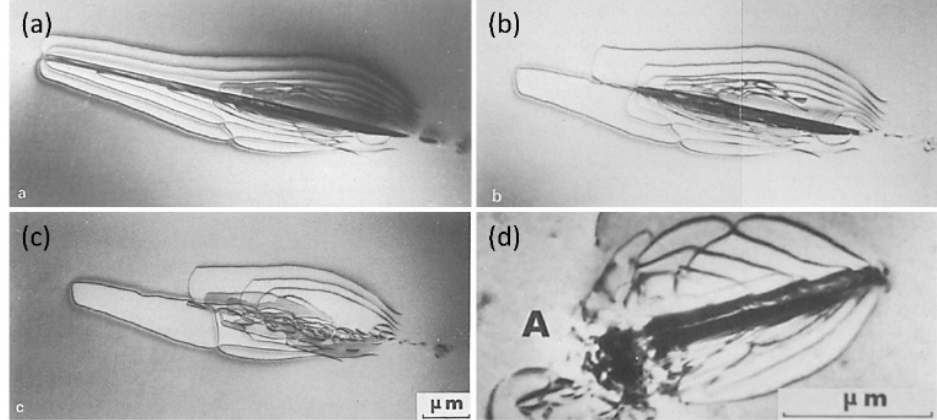
Figure 4. Precipitation–memory effect: ( a ) γ -ZrH at room temperature, ( b ) disappearance of γ -ZrH at 77 °C, ( c ) remaining dislocation structures at 117 °C, ( d ) reprecipitation of γ -ZrH after cooling from 142 °C to 42 °C [59]. Reprinted with permission from [59]; Copyright 1978 Elsevier.